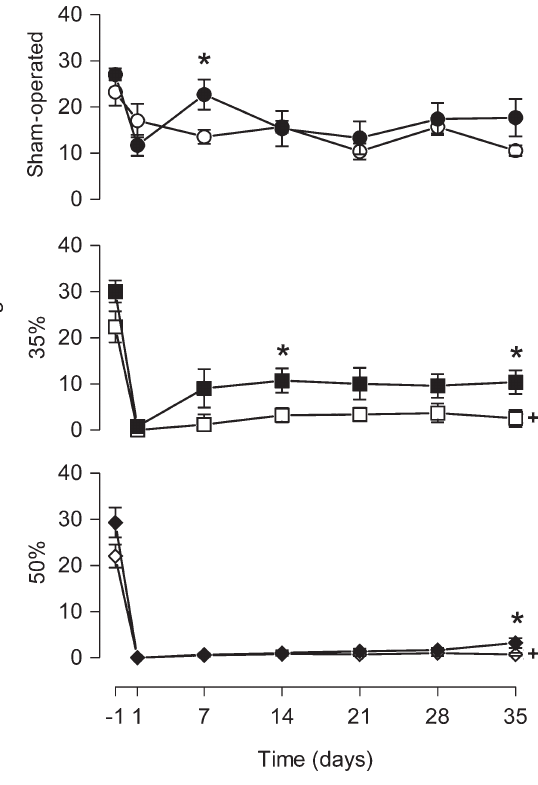
Figure 3. Melatonin treatment increased the rearing behavior. Rearing behavior in an open arena was measured 24 h before (-1) and 1, 7, 14, 21, 28, and 35 days after narrowing of the spinal cord canal. Each point represents the mean ± SE for 9-11 rats. *P , 0.05 compared to the vehicle-treated group (independent Student t -test). + P , 0.0001 compared to sham-operated group from vehicle-treated animals at all times after narrowing of the spinal cord canal (ANOVA with the Duncan post hoc test). No difference was observed between the 35%-V and 50%-V groups (P . 0.05). 35% = 35% narrowing group; 50% = 50% narrowing group. Open symbols = vehicle-treated groups; filled symbols = melatonin-treated